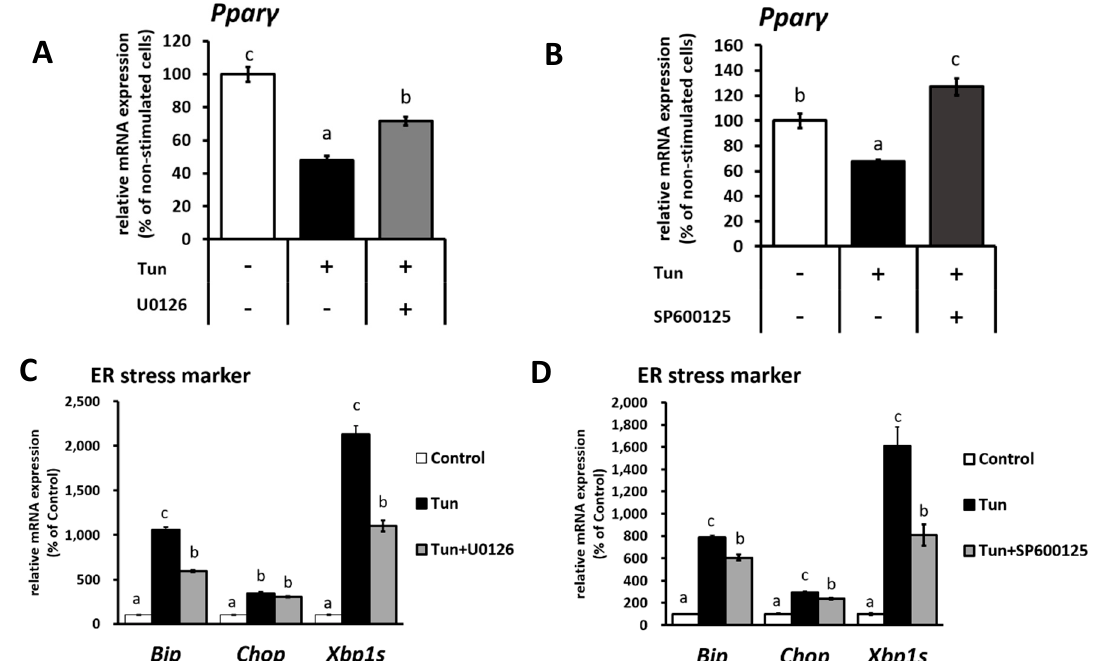
Figure 2. ER stress decreases Ucp1 activator, peroxisome proliferator-activated receptor γ ( Ppar γ ) mRNA expression through ERK and JNK pathway in IWAT cells. Ppar γ and ER stress marker ( Bip , Chop , and X-box binding protein 1 splicing- Xbp1s ) mRNA expression in cells treated with ( A , C ) 100